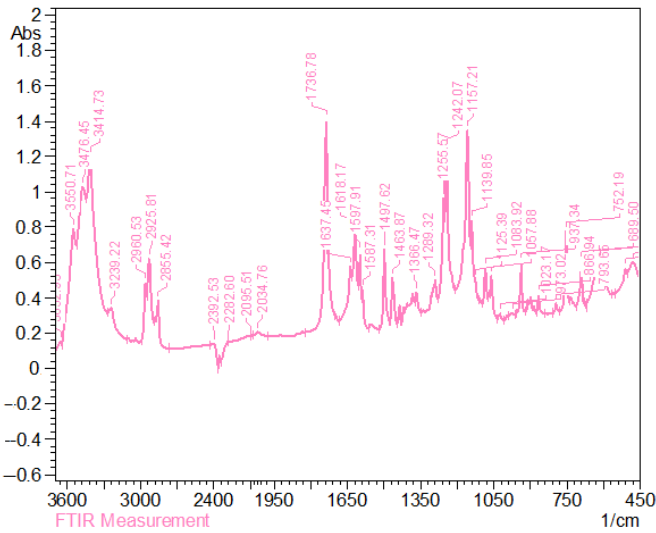
Figure 2. FTIR spectra of decyl butoxyethyl adipate.